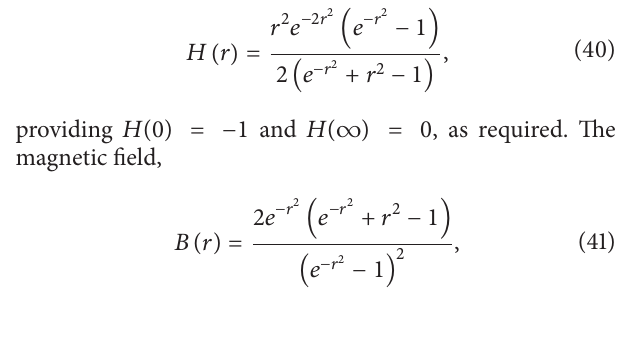
nontrivial numerical solutions of the same kind were also studied in